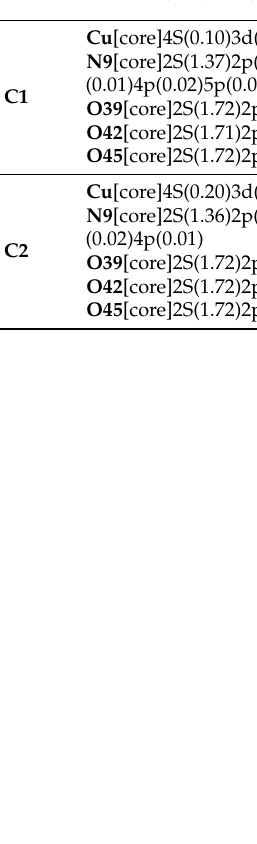
Table 10. Calculation QTAIM, ELF, LOL parameters of the cps and length between atoms in